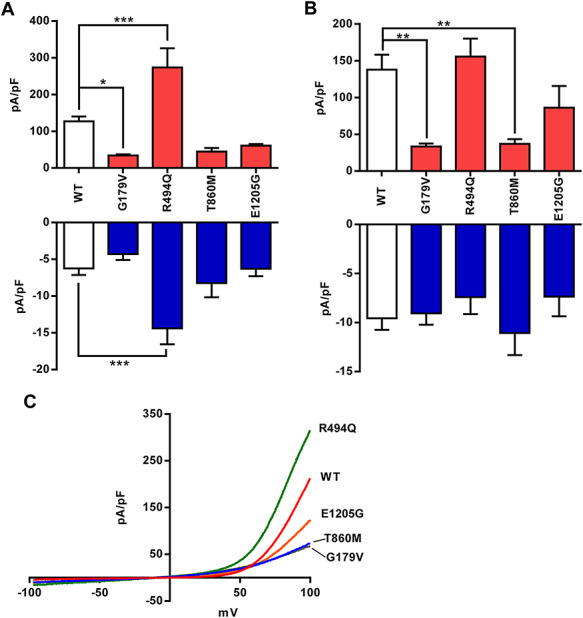
Stillbirth TRPM7 variants alter current density in a cell-specific manner. (A) Summary data of average TRPM7 current density at +80 mV (red) and −80 mV (blue) from CHO-K1 cells (WT n = 28, variant n = 13–8). (B) Summary data of average TRPM7 current density at +80 mV (red) and −80 mV (blue) from CHO-K1 cells (WT n = 24, variant n = 12–7). (C) Whole-cell current trace recordings from CHO-K1 cells transiently transfected with WT, p.G179V, p.R494Q, p.T860M and p.E1205G TRPM7. *—P < 0.05, **—P < 0.01, ***—P < 0.001.